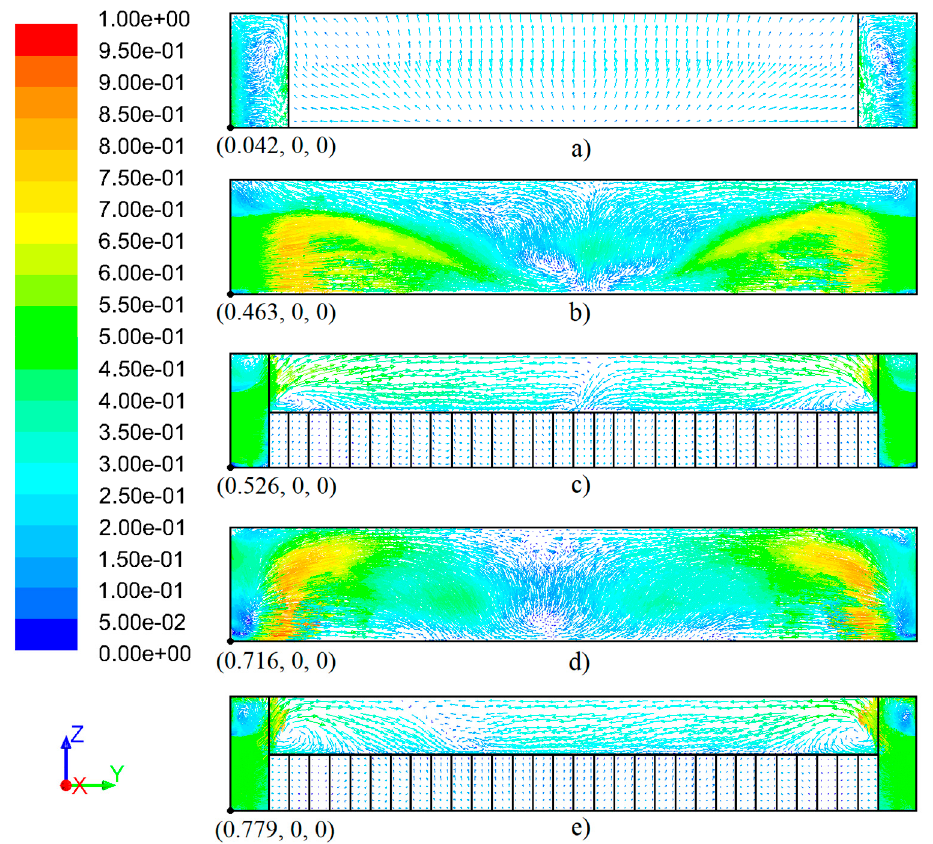
Figure 25. The results of the dimensionless velocity vectors for the maximum air flow velocity in the y–z plane represented through the planes ( a ) x adm = 0.042; ( b ) x adm = 0.116; ( c ) x adm = 0.526; ( d ) x adm = 0.589; ( e ) x adm = 0.779. Appl. Sci. 2019 , 9 , x FOR PEER REVIEW 26 of 30